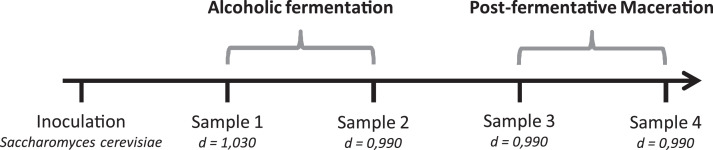
Sampling method.